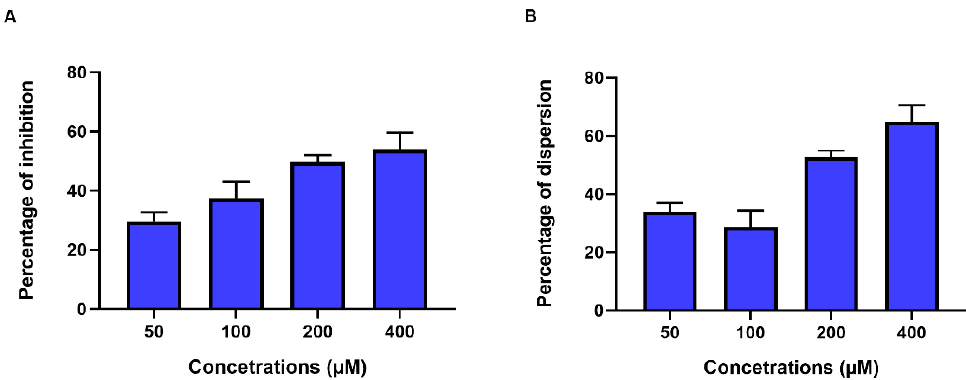
Figure 2. Inhibition and dispersion of C. jejuni 11168-O biofilms in the presence of ex-c-di-GMP at different concentrations. ( A ). Inhibition of biofilm formation by different concentrations of ex-c-di- GMP. ( B ) Dispersion of the existing biofilm induced by different concentrations of ex-c-di-GMP. Data are presented as mean ± standard error (3 or more biological repeats) of the percentage of inhibition (normalized to untreated control).